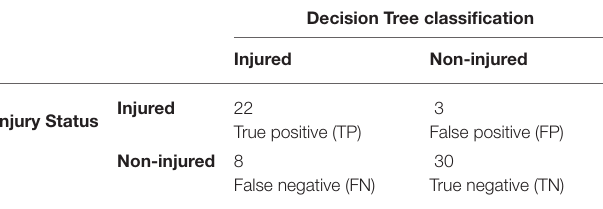
TABLE 2 | A 2 × 2 contingency table for the Decision Tree